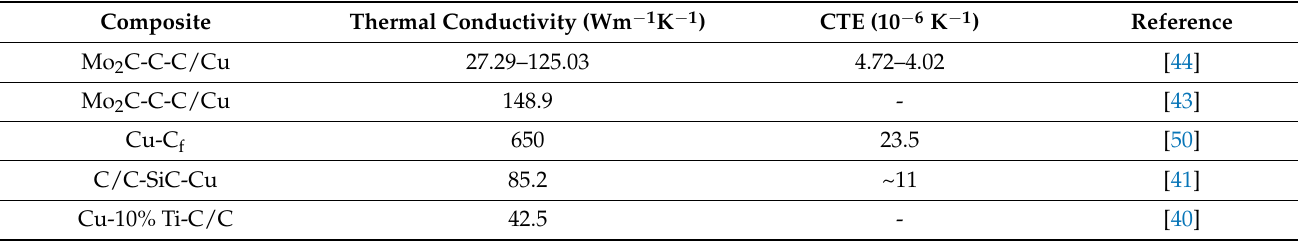
Table 6. Thermal properties of